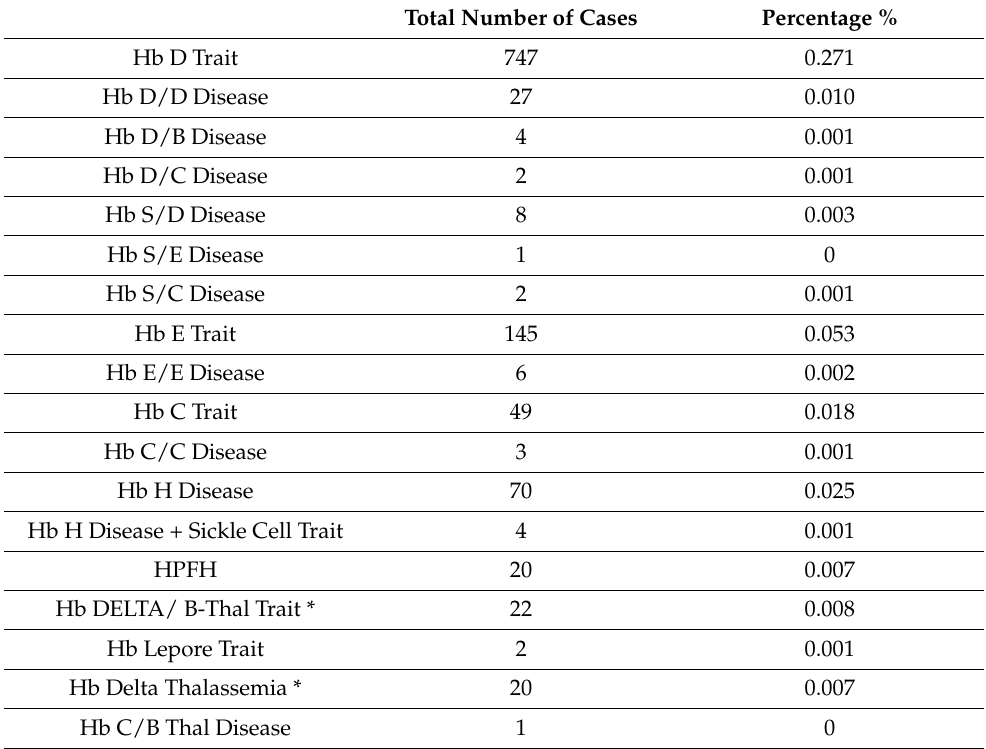
Table 3. Some of the hemoglobin variants detected during screening from 2009 to August 2020.